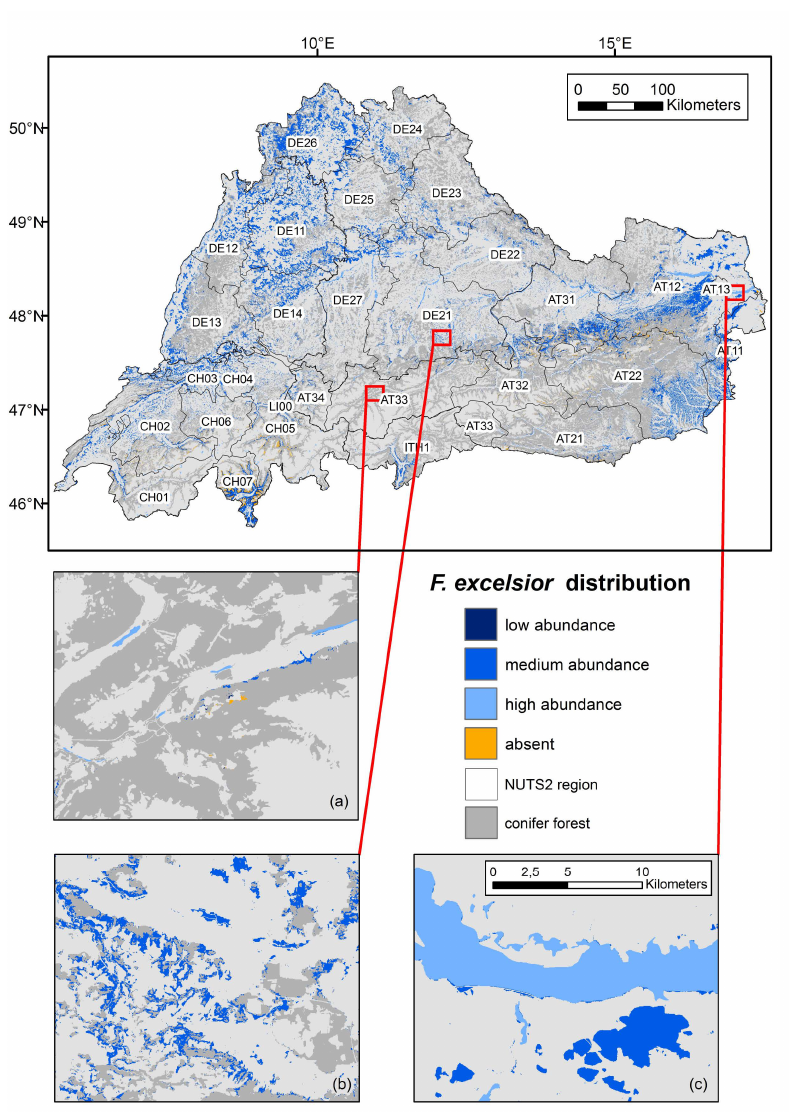
Figure 3. Risk map of future infestation by Agrilus planipennis based on F. excelsior -distribution for Austria, Bavaria, Baden-Wurttemberg, Liechtenstein, Switzerland and South Tyrol; with examples of landscapes differing in abundance of F. excelsior in the study region (see Table 2 for definitions): ( a ) mountainous landscape of the upper Inn Valley in Tyrol (near Innsbruck); ( b ) an agricultural landscape in the Bavarian Alpine Foothills (near Miesbach); ( c ) lowland floodplain forests along the Danube (east of Vienna) and adjacent remnant forests in a intensively used agricultural landscape. The acronyms and location of the NUTS2 (second-level Nomenclature of Units for Territorial Statistics) regions used in Table 2 are given. Study region: Austria (AT), Switzerland (CH), South Germany (DE), South Tyrol (ITH), and Liechtenstein